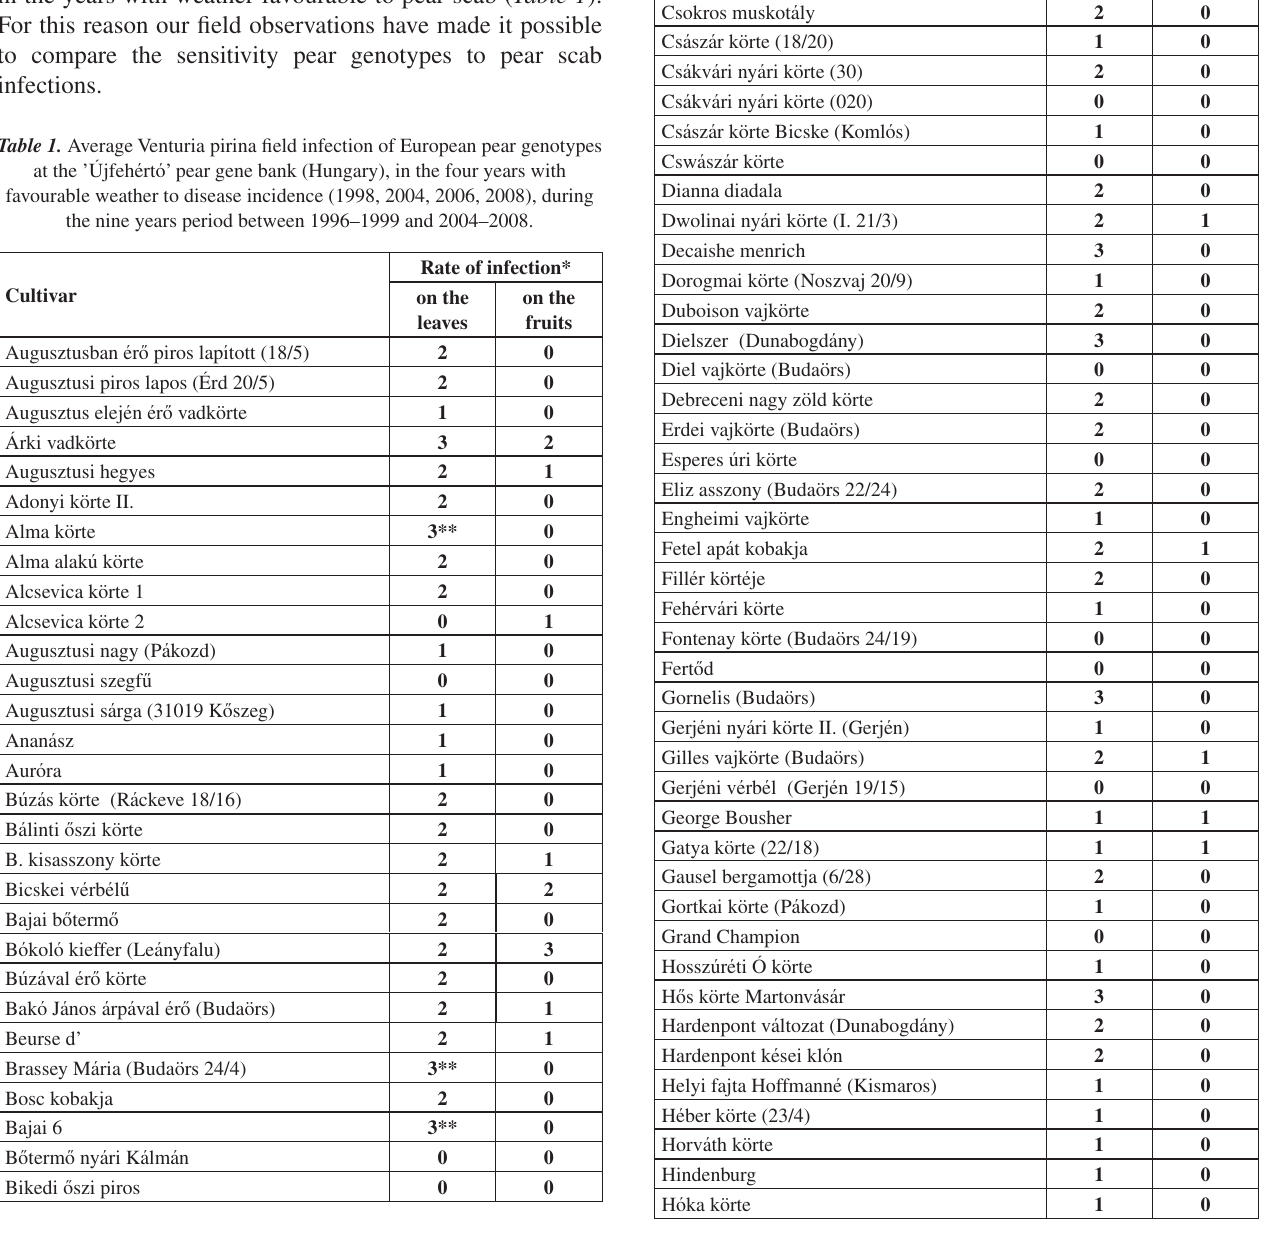
Rate of infection* on the on the leaves